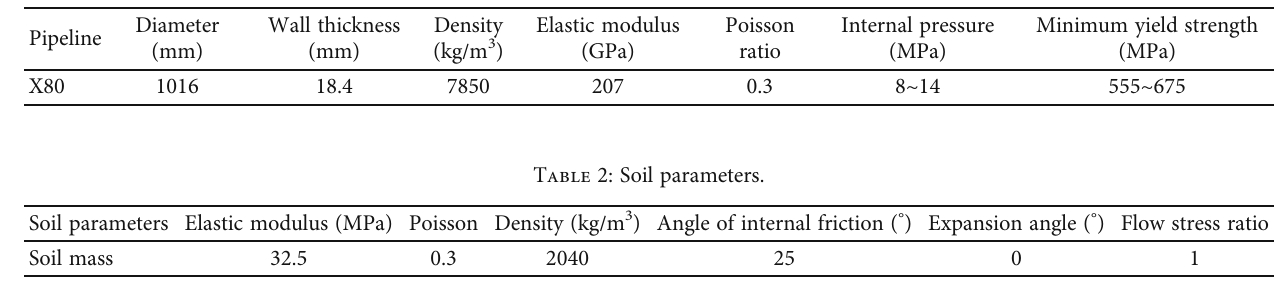
Figure 1: Finite element calculation model. Table 1: Pipeline parameters.